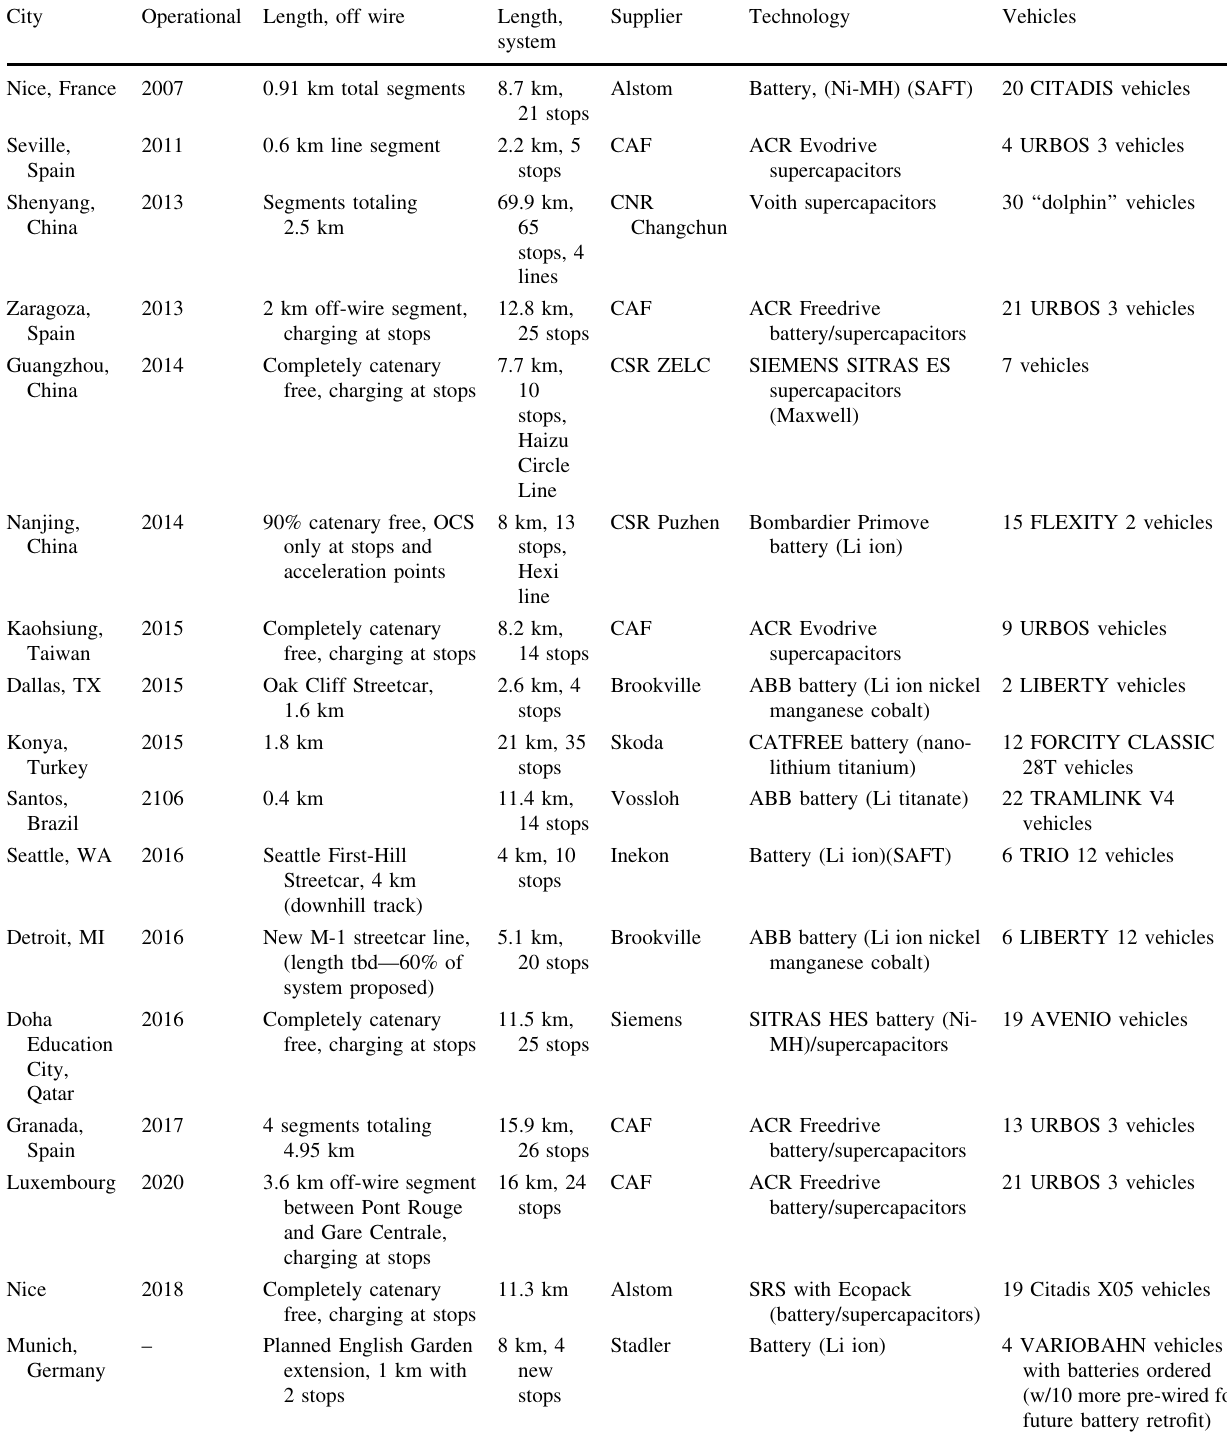
Table 3 Onboard energy storage systems for off-wire operation ‘‘OESS’’. ( Source : [9])